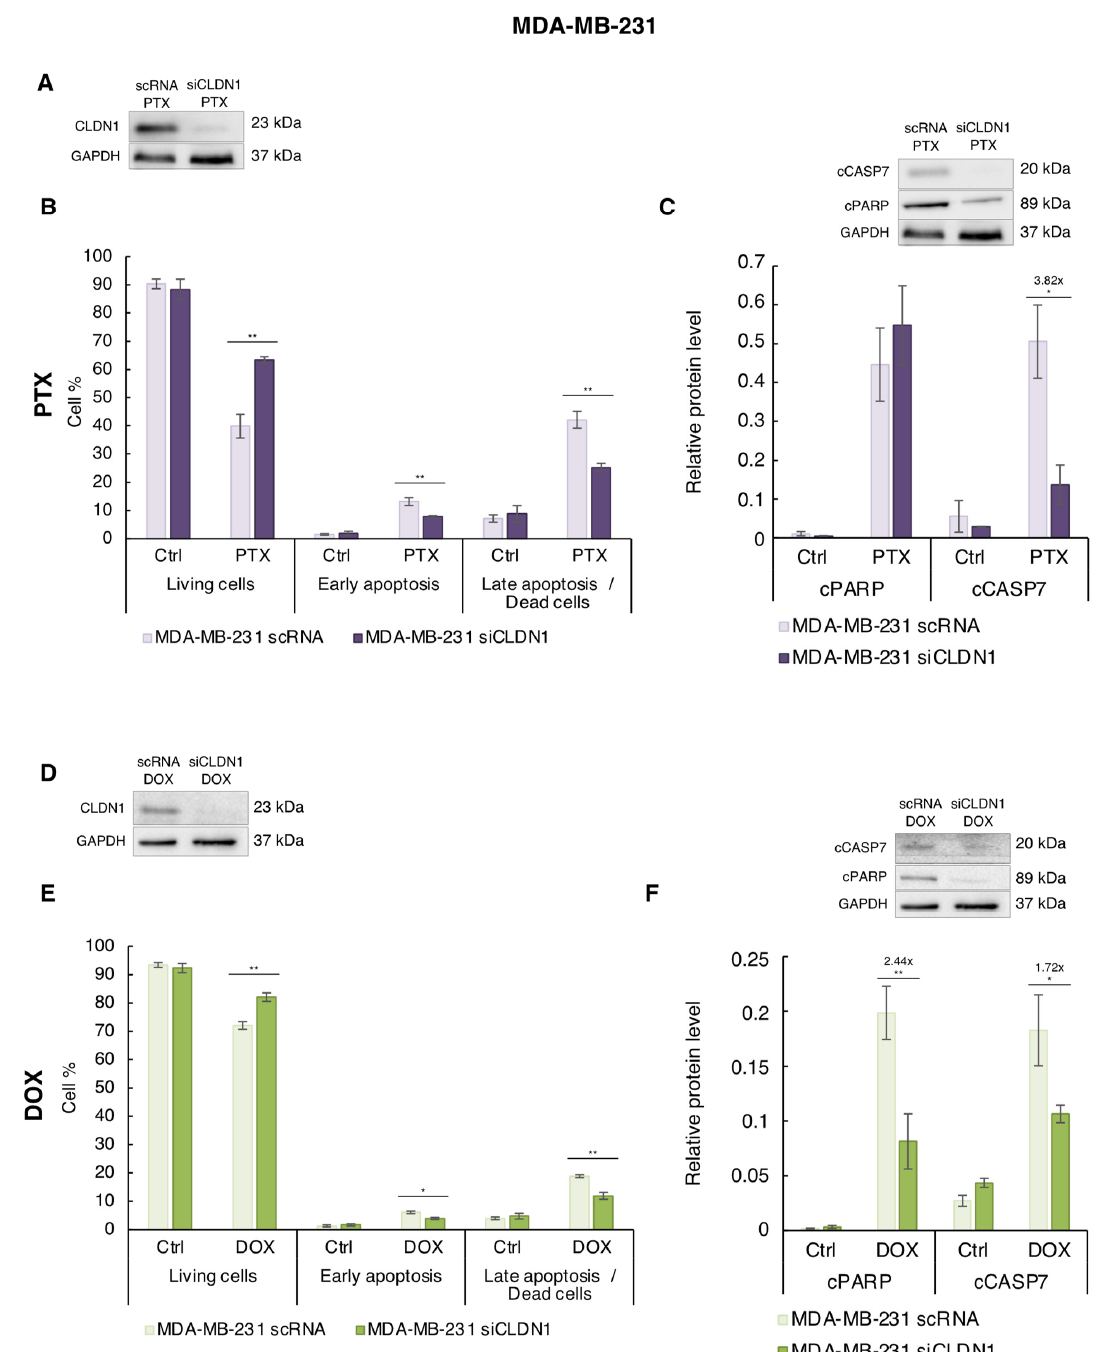
Figure 5. CLDN1 expression is involved in MDA-MB-231 cells sensitivity to PTX and DOX. MDA-MB-231 cells were transfected with a siRNA directed against claudin-1 (siCLDN1) or with a scramble scRNA. 7 h after transfection, cells were treated for 72 h with ( A – C ) 5 nM of PTX, ( D – F ) 86 nM of DOX or with solvent (Ctrl). ( A , D ) CLDN1 expression was studied by western blot. ( B , E ) MDA-MB-231 cells were co-labeled with annexin V coupled to FITC and with propidium iodide and the living, early- and late-apoptotic cells were analyzed by flow cytometry. ( C , F ) Cleavage of apoptotic markers PARP-1(cPARP) and caspase 7 (cCASP7) expressions were analyzed by Western blot. Relative protein level expressions correspond to the protein of interest on GAPDH ratios. The values represent the means ± SEM of three to five different experiments. A p -value of less than 0.05 was considered statistically significant with * p < 0.05, ** p < 0.01. The uncropped blots are shown in File